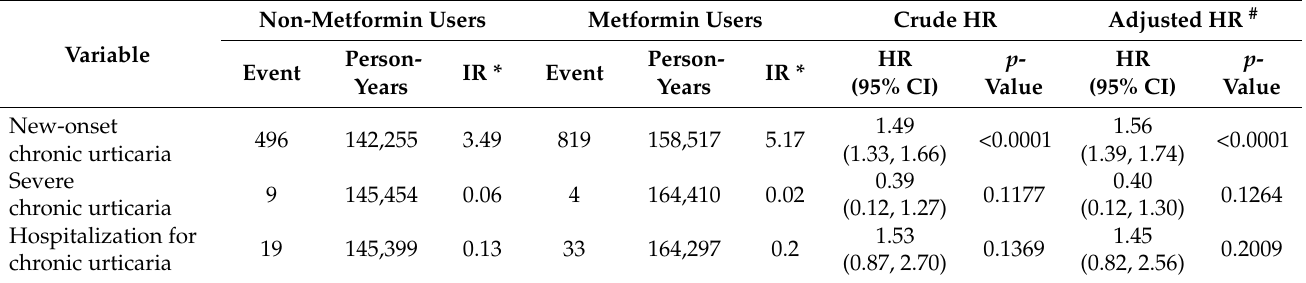
Table 2. Incidence and HRs of main outcomes associated with metformin users compared with nonusers in patients with T2D.